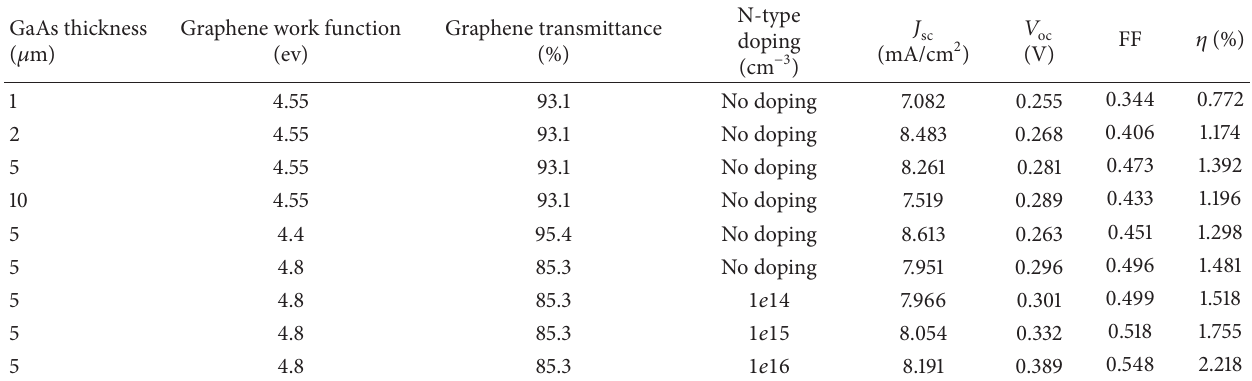
Table 2: Efficiency versus GaAs thickness, graphene work function and transmittance, and n-type doping concentration under AM1.5